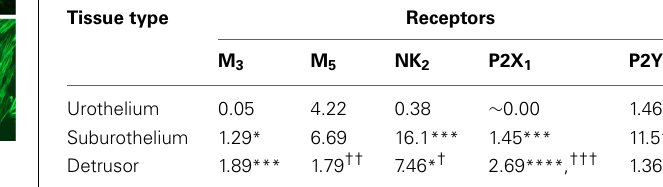
FIGURE 2 | Fluorescent immunocytochemical characterization of cultured urothelial cells (A–C), suburothelial cells (D–F), and detrusor smooth muscle cells (G–I). Cells (A,D,G) were immunostained by AE1/AE3 (cytokeratin marker), (B,E,H) by vimentin, and (C,F,I) by α -SMA (smooth muscle marker). Cells were double stained with DAPI (cell nuclei, blue). All panels are shown at the same magnification. Bar = 100 μ m.